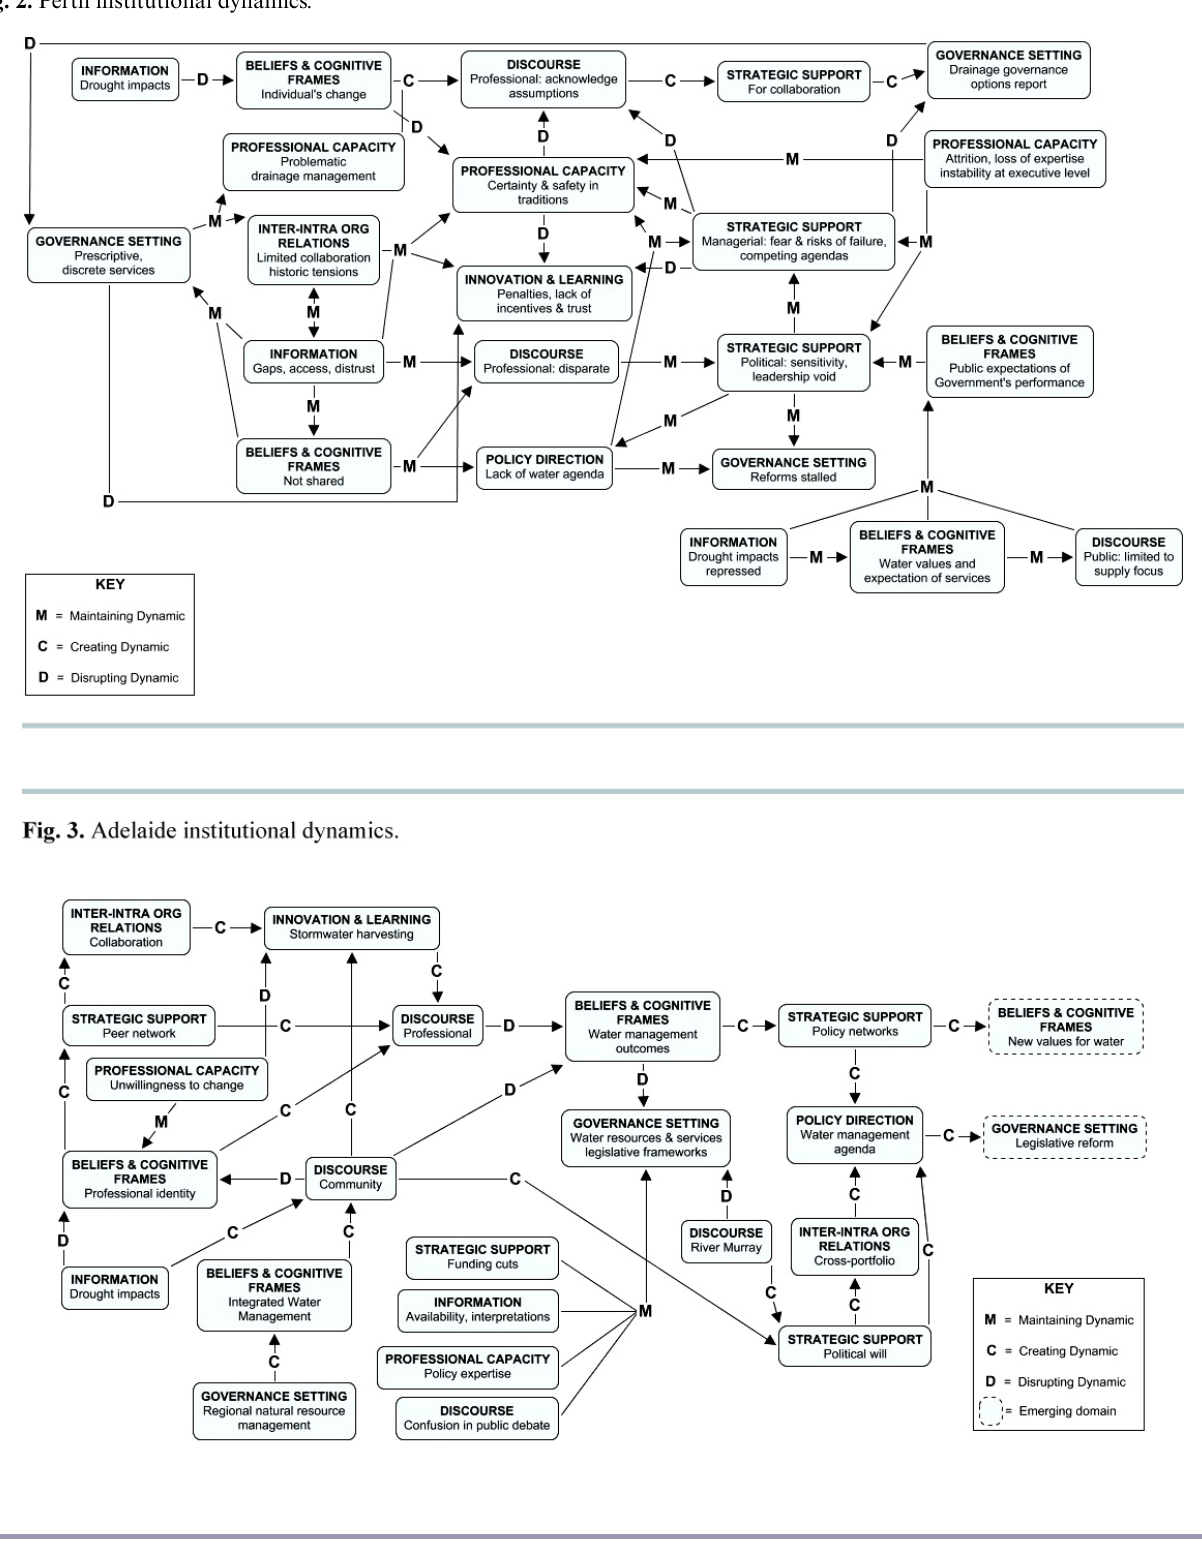
Fig. 2. Perth institutional